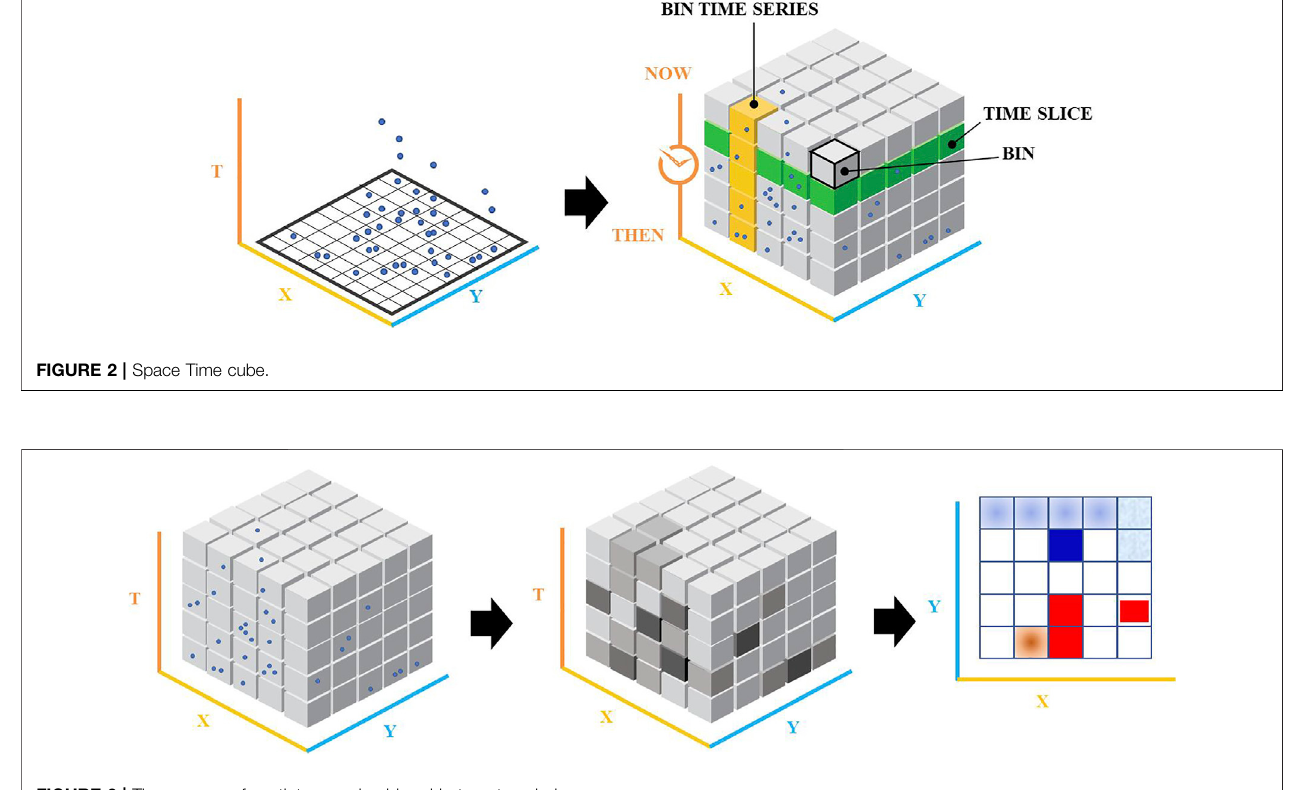
FIGURE 3 | The process of spatiotemporal cold and hot spot analysis.